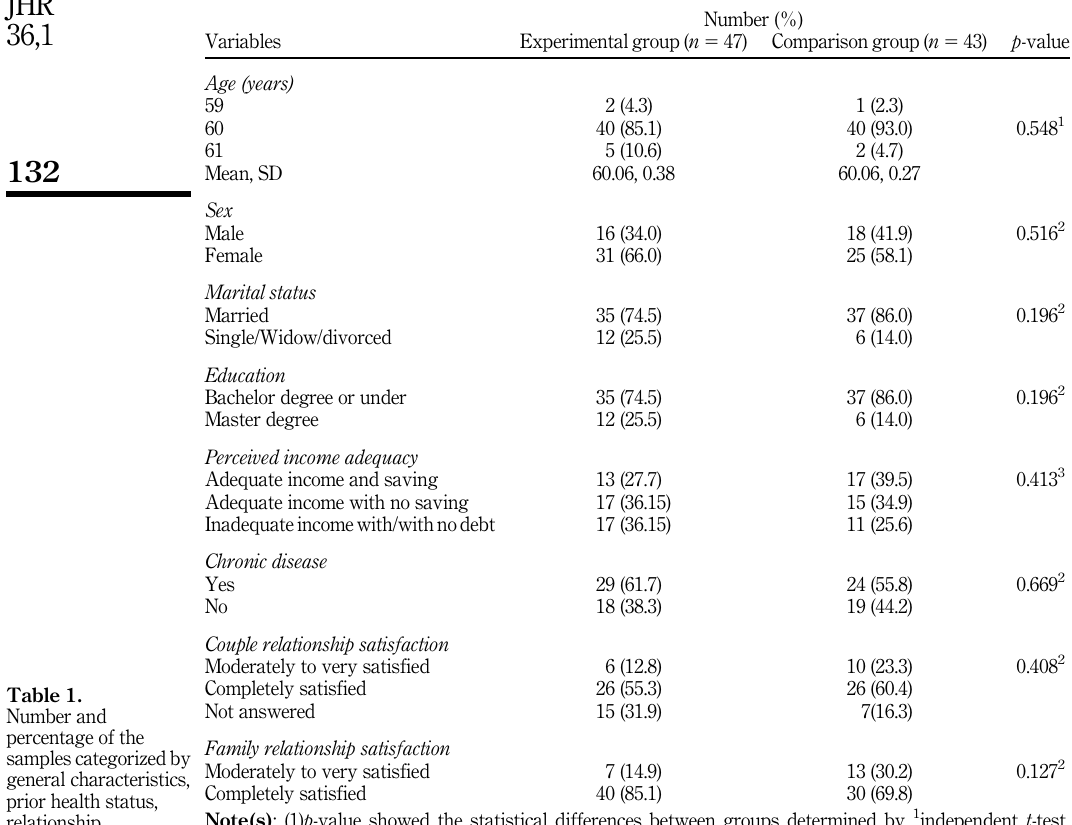
percentage of the samples categorized by general characteristics, prior health status, relationship